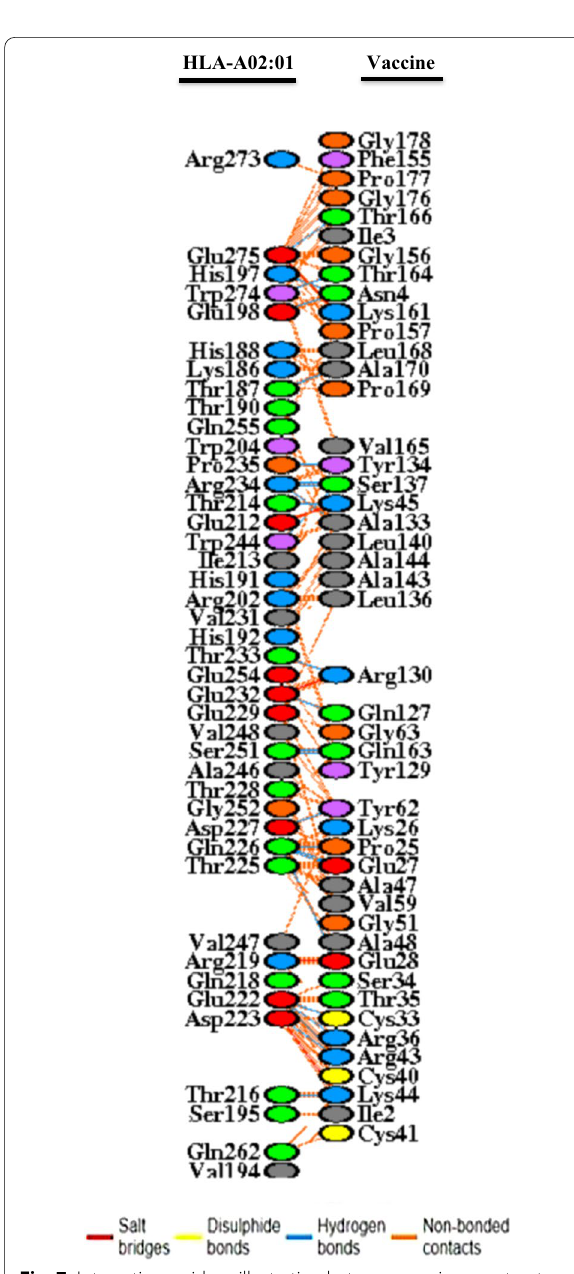
Fig. 7 Interacting residues illustration between vaccine construct and HLA-A02:01: A total of 46 residues of the vaccine associated with 42 residues of the HLA-A02:01 molecular. A number of 25 hydrogen bonds (blue line) were formed between the residues of the HLA-A02:01 molecule and the residues of the